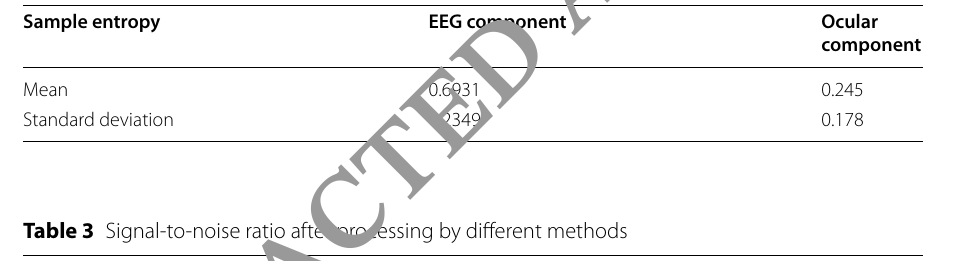
Table 3 Signal-to-noise ratio after processing by different methods After bandpass